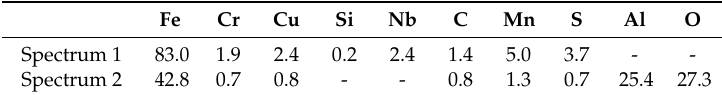
Table 1. Composition of the nanoscale inclusions in Figure 2 (wt %).